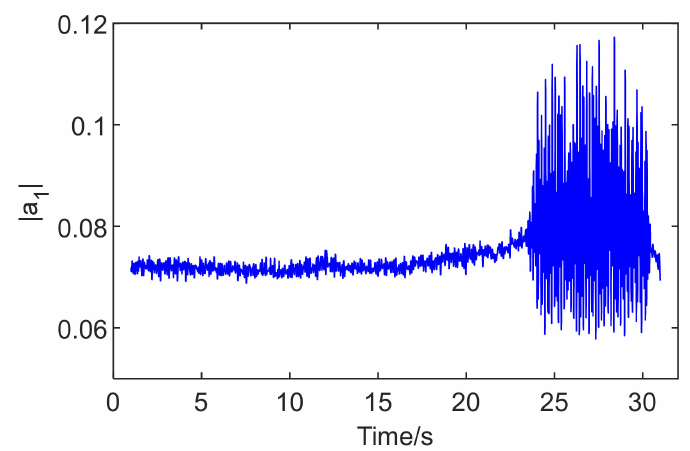
Figure 4. The first-order spatial mode amplitude |a1|in development process.